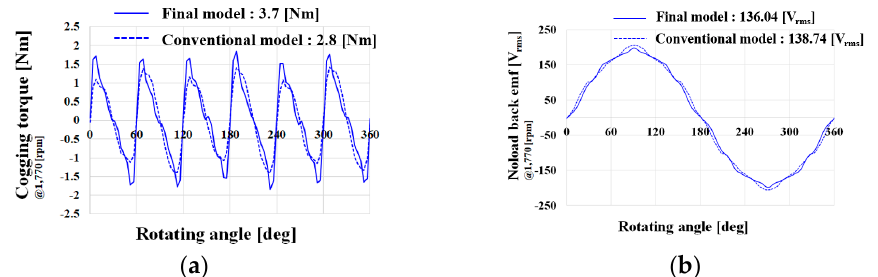
Figure 19. Cogging torque waveforms and no-load back EMF at rated speed of conventional model and final model: ( a ) Cogging torque, ( b ) Noload back EMF.